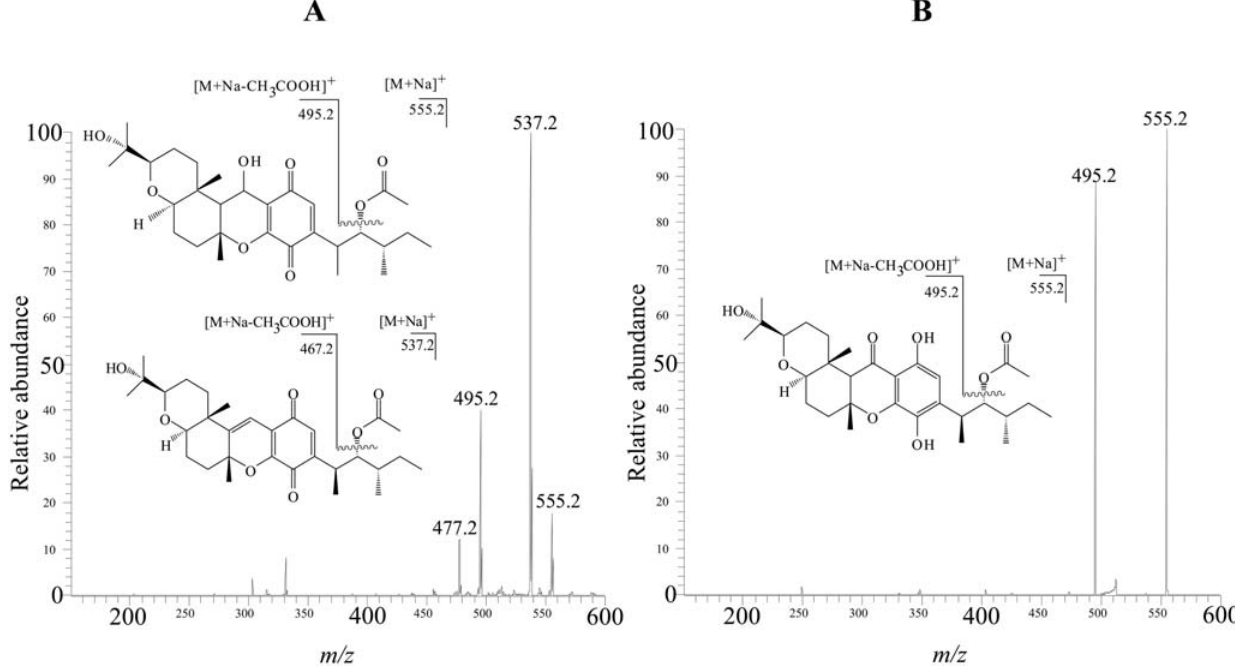
Figure 4. ESI-MS-MS in the positive ion mode showing the main fragments generated by cochlioquinone A (panel A) and isocochlioquinone A (panel B). Both compounds show sodiated quasi-molecular ion peaks [M + Na] + at 555 daltons and the loss of acetic acid ( D m/z= 60 daltons) from the side chain. In addition, the hydroxyl group in the pyrane ring of cochlioquinone A is responsible for the observed loss of water ( D m/z =18